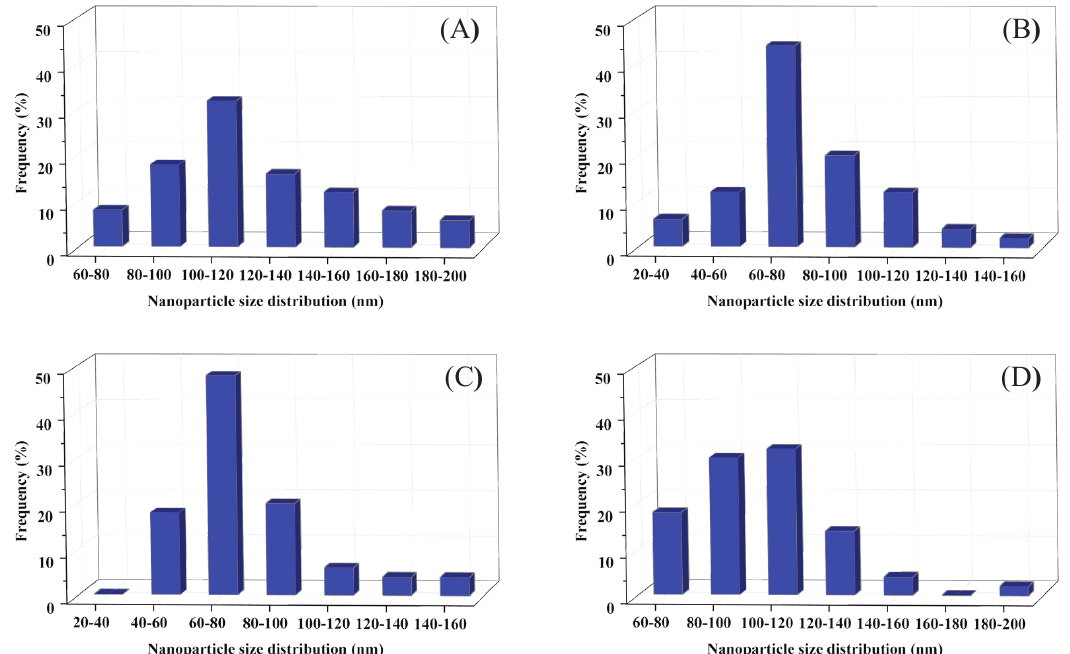
Figure 3: The nanoparticles size distribution of (A) undoped TiO 2 , (B) 0.25% Fe-doped TiO 2 , (C) 0.5% Fe-doped TiO 2 and (D) 0.75% Fe-doped TiO 2 powder.